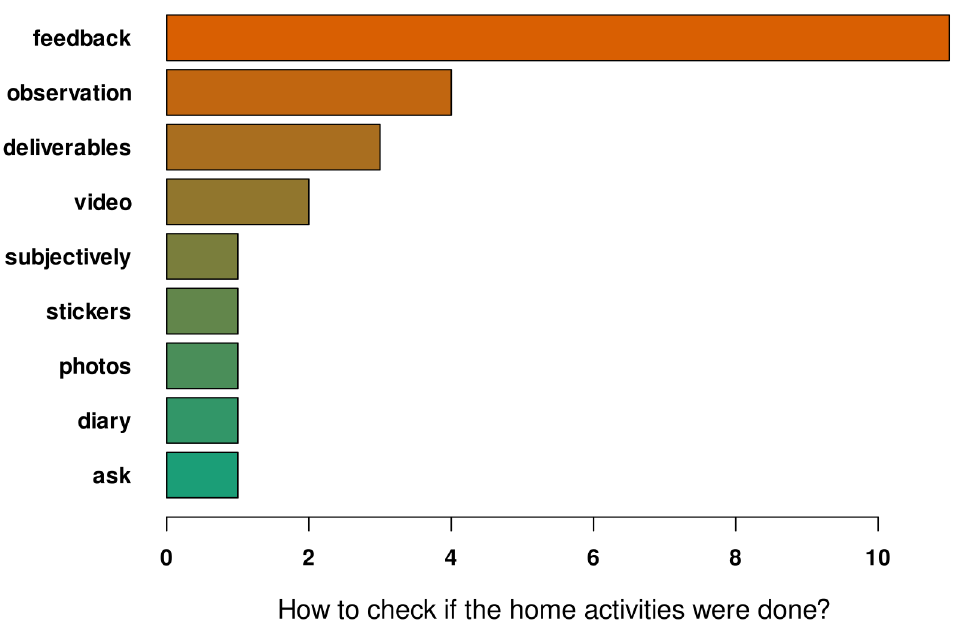
Figure 11. How do SLTs verify if the activities sent home were